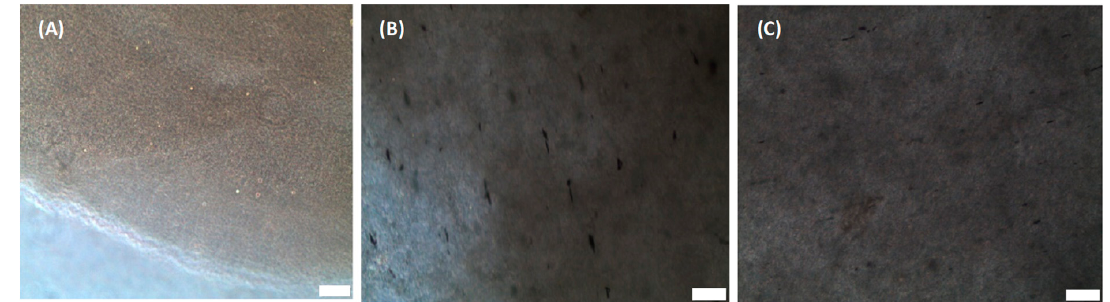
Figure 1. Phase contrast microscope image of ( A ) plain collagen scaffolds, ( B ) phase contrast microscope image of scaffolds fabricated using the “magnetic particle string” method, and ( C ) phase contrast microscope image of scaffolds fabricated using the “magnetic anchor” method. Scale bar = 50 µm.